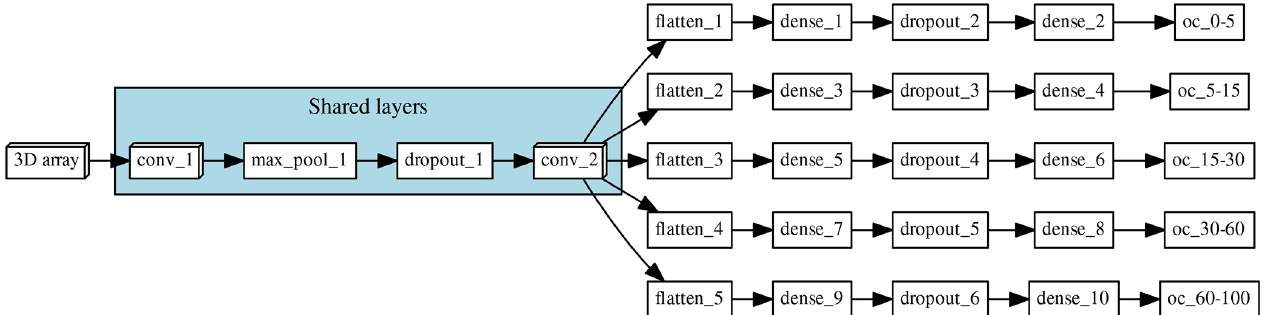
Figure 1. Architecture of the multi-task network. “Shared layers” represent the layers shared by all the depth ranges. Each branch, one per depth range, first flattens the information to a 1D array and is followed by a series of two fully connected layers and a fully connected layer of size = 1, which corresponds to the final